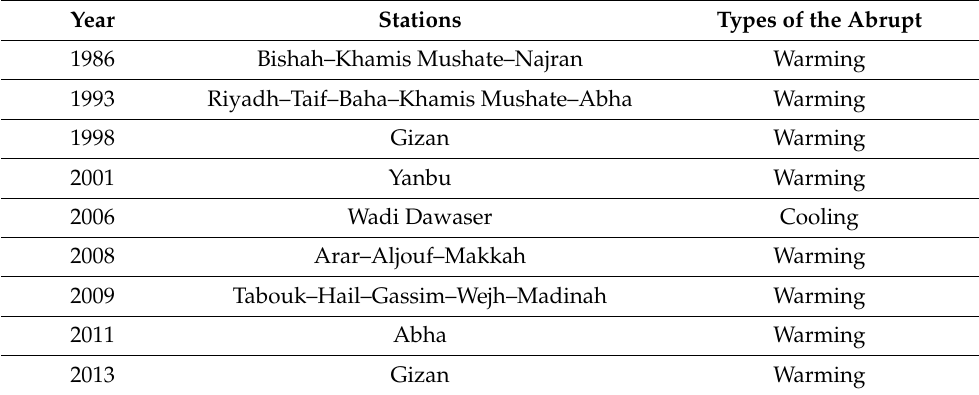
Table 4. The detected years of abrupt warming (cooling) of the Winter Air Temperatures of Saudi Arabia stations by the Mann–Whitney test for abrupt